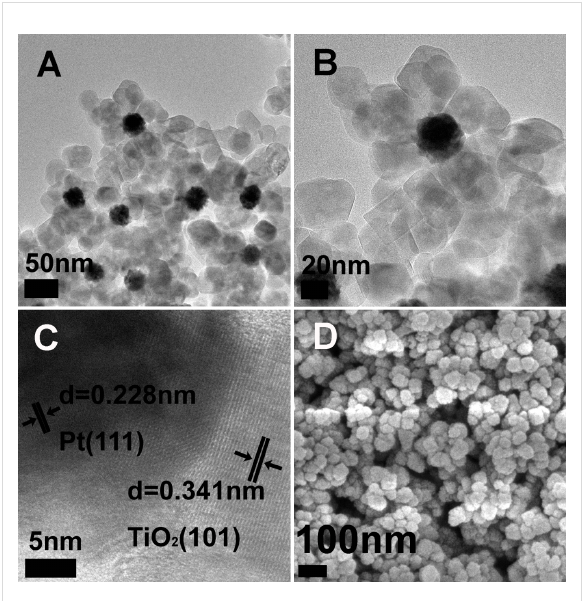
Figure 2: TEM and SEM images of the Pt@TiO 2 sample. (A) (B) TEM images of Pt@TiO 2 , (C) HRTEM images of Pt@TiO 2 , (D) SEM image of Pt@TiO 2